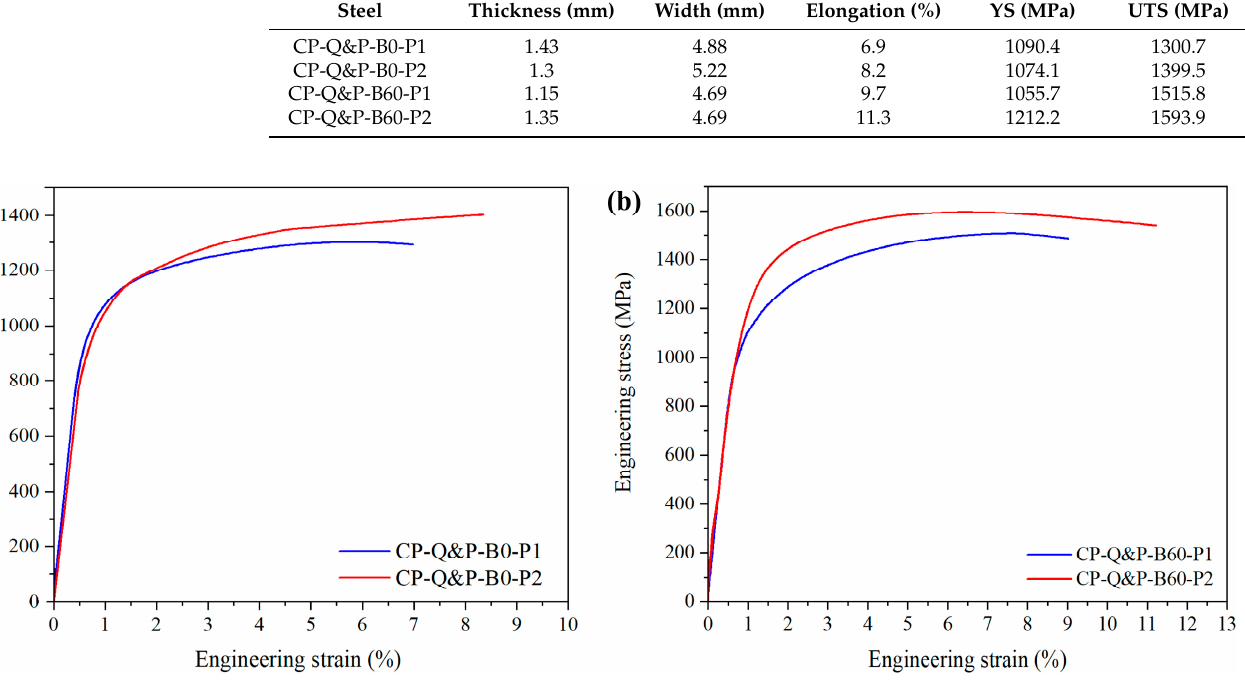
Figure 15. Engineering stress-strain curve for Q&P heat-treated CP steel with P1 and P2 steps: ( a ) boron-free (CP-Q&P-B0) steel, and ( b ) boron-containing (CP-Q&P-B60) steel.